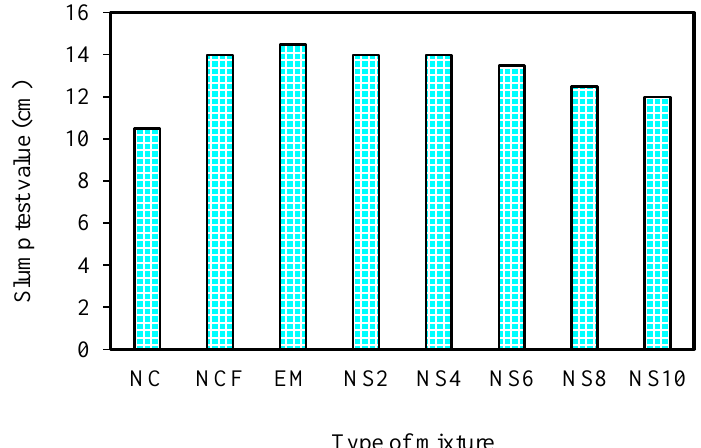
Figure 6. Slump test values of prepared mixtures.